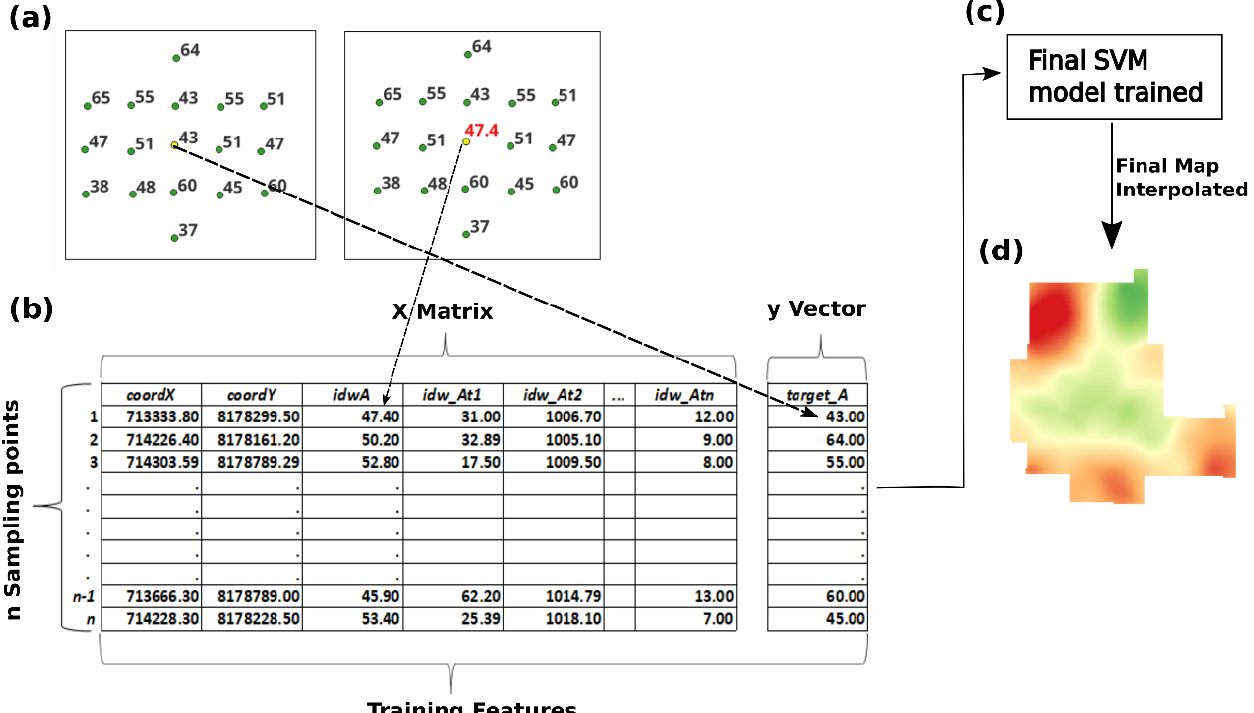
Figure 5. Construction of the ML model. ( a ) Selection of the 16 closest neighbors to the point where the user wishes to estimate the attribute value using the IDW method. ( b ) Definition of the ML model (Train_Features) for the methods SVM1 and SVM2 : features (X matrix) and target (y vector). ( c ) SVM model trained for the methods SVM1 and SVM2 . ( d ) Map interpolated from the test set. For SVM1 , the features consisted of the coordinates ( coordX and coordY ) of the point and the IDW value of the variable ( y ) using the 16 neighbors closest to the sampled point, within the defined search radius of the attribute to be estimated. The variable to be interpolated ( y ) represents the observed soil attribute, for which the user wishes to predict its values at unsampled locations. In this case study, the variables are P, K + , Ca 2+ and Mg 2+